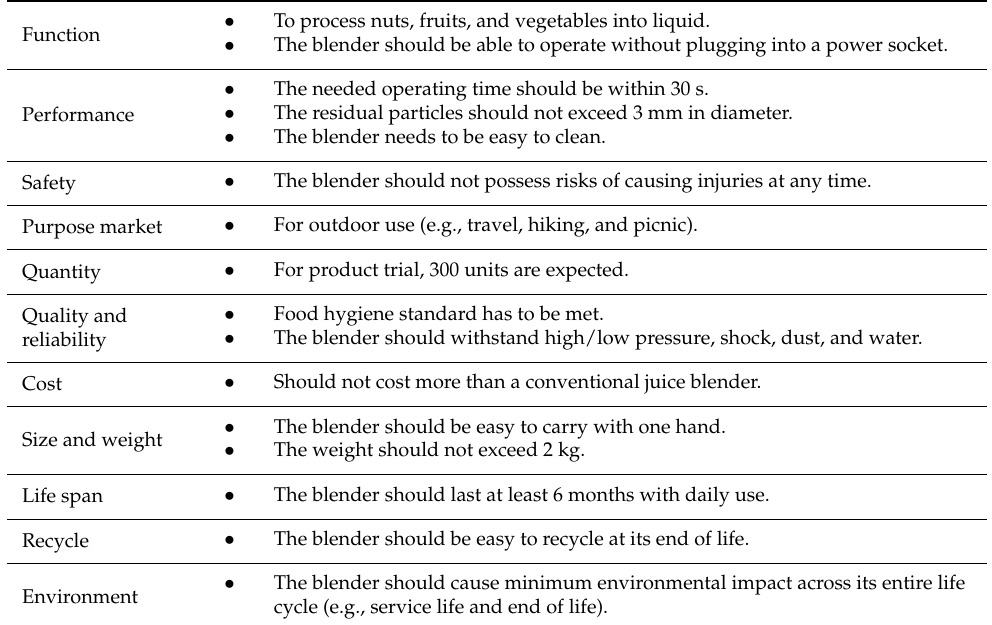
Table 7. Key product design